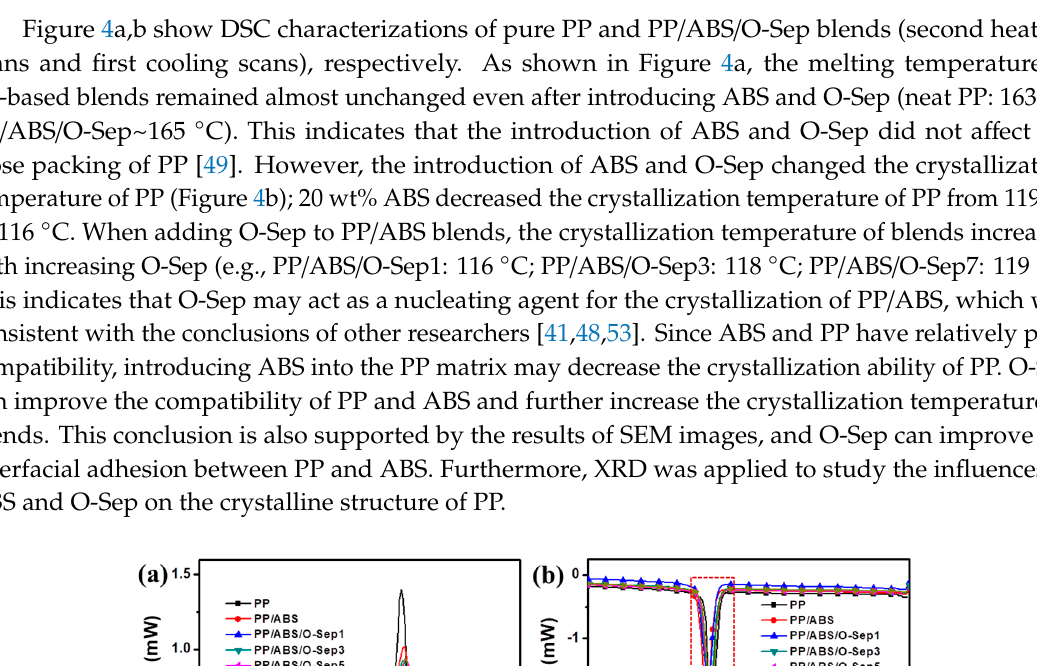
Figure 3. ( a ) TG and ( b ) DTG curves of PP and PP/ABS/O-Sep nanocomposites (heating rate 20 °C/min).